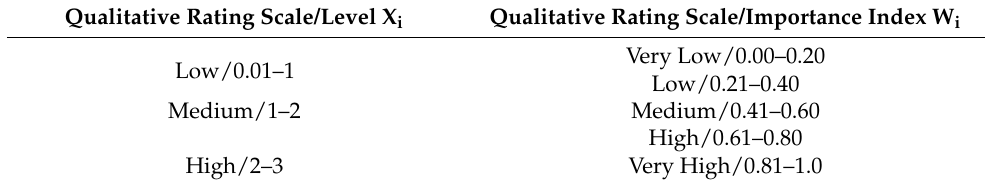
Table 1. Rating scale per level X i , and importance index W i